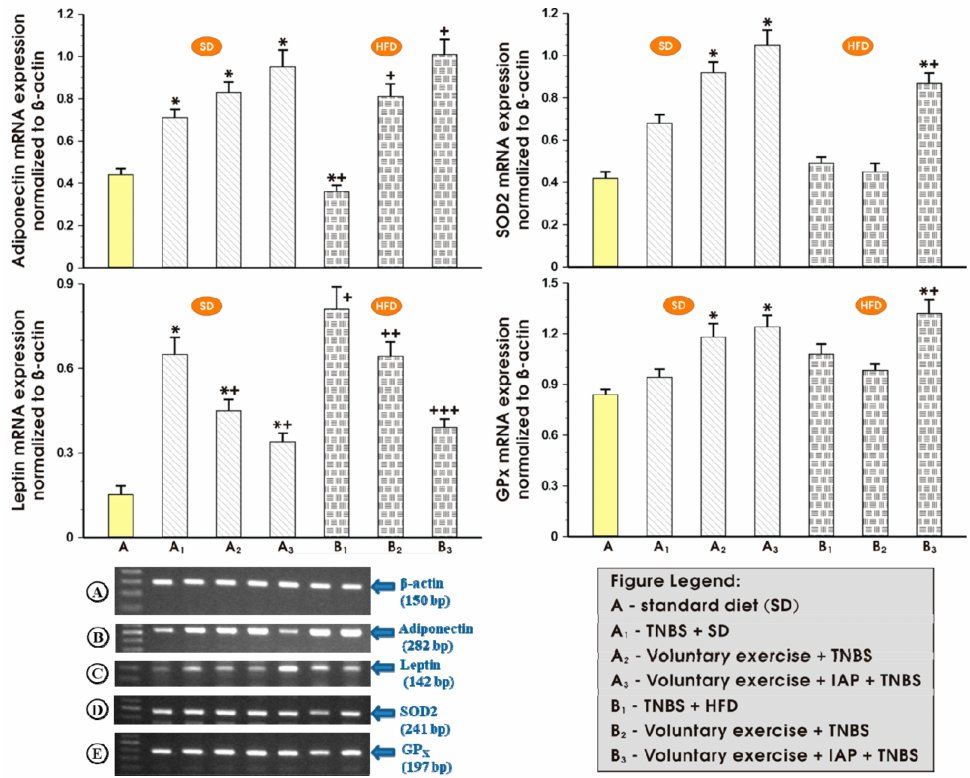
Figure 4. Expression of adiponectin, leptin, SOD2 and GPx mRNA determined by real-time quantitative PCR in untrained and training colitis mice with or without combination with IAP. Analysis by qualitative RT-PCR on an agarose gel of mRNA expression of β -actin ( A ), adiponectin ( B ), leptin ( C ), SOD2 ( D ) and GPx ( E ) in the colon mucosa of non-exercising or exercising mice with colonic inflammation treated or not treated with IAP. Data reflecting the mean ± S.E.M. of six animals are shown for each experimental group, * significantly different ( p < 0.05) from the corresponding values in non-training SD-fed and colitis-free mice, * + significantly different ( p < 0.05) from the corresponding values in non-exercising colitis mice kept on SD or HFD, + significantly different ( p < 0.05) from exercising SD or HFD fed colitis mice, ++ significantly different ( p < 0.05) from non-exercising mice fed HFD, +++ significantly different ( p < 0.05) from exercising colitis mice kept on